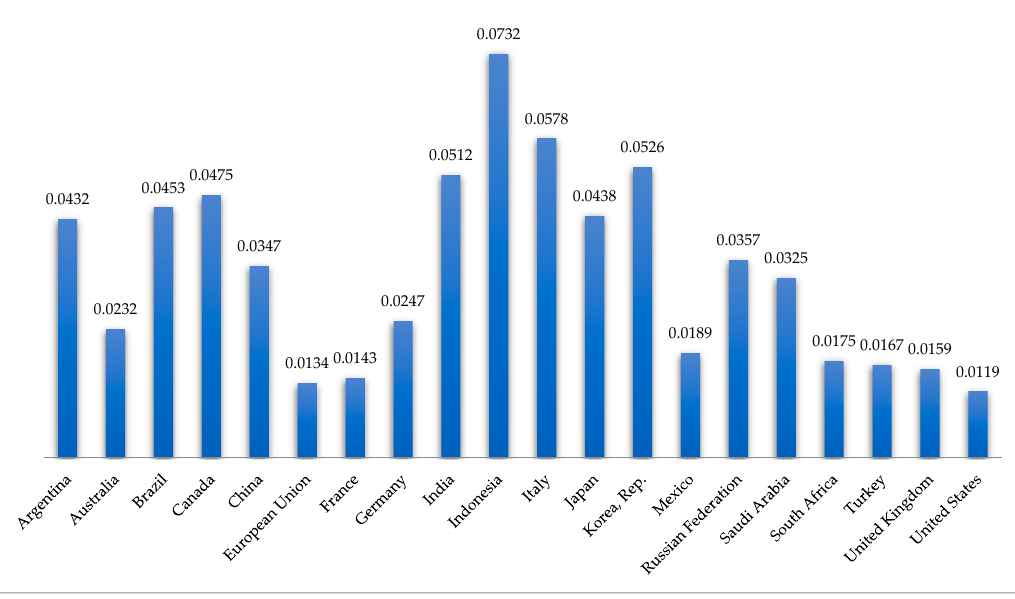
Figure 5. Mean absolute error (MAE) results for ANFIS models.